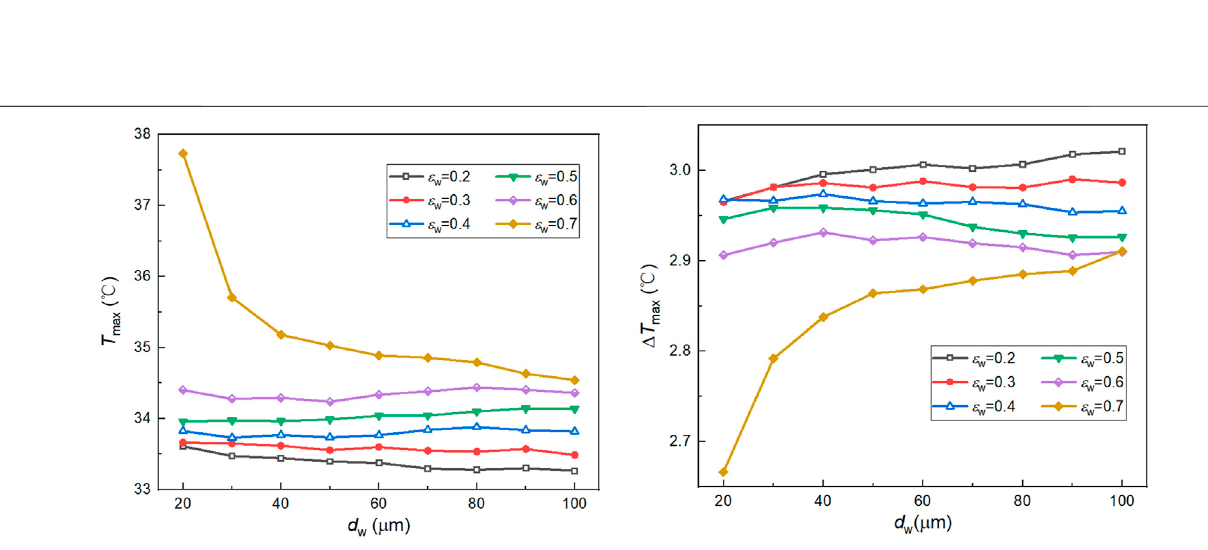
Frontiers in Energy Research |